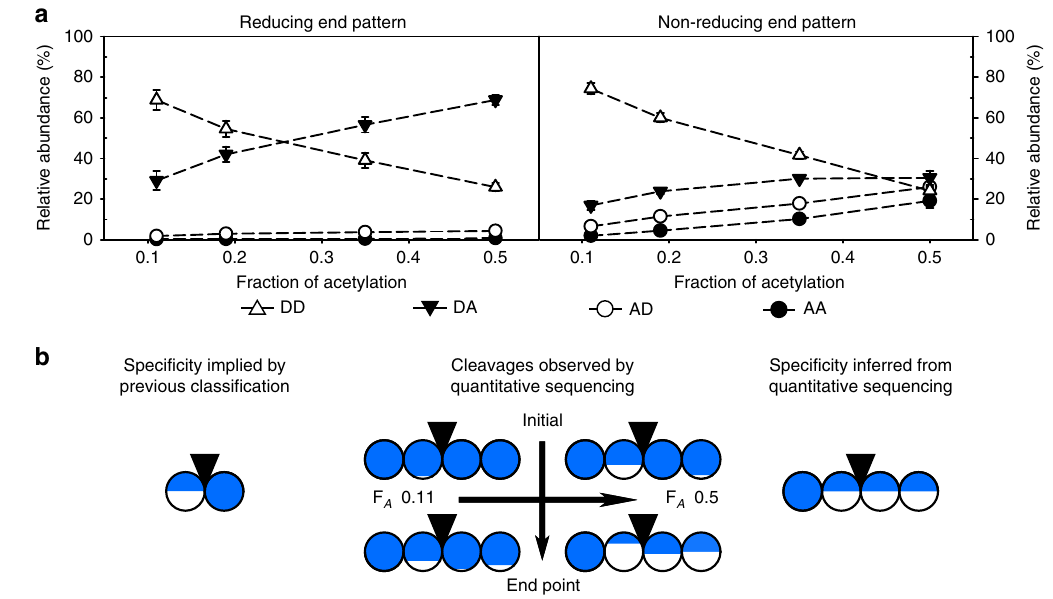
Fig. 2 Speci fi city of the representative class I chitosanase CSN-174 inferred from its products. ( a ) The patterns of acetylation of the two terminal sugar units were analyzed for different F A of the substrates by quantitative sequencing of the products at the endpoint of enzymatic hydrolysis. The molar fractions of all possible diads (DD, DA, AD, and AA) are shown. ( b ) The speci fi city of class I chitosanases implicated by the established qualitative classi fi cation system compared to the speci fi city of CSN-174 (a model class I chitosanase) inferred from the cleavages observed by the quantitative sequencing of its products ’ sugar moieties. Diad frequencies at the early time points of enzymatic hydrolysis are taken from Supplementary Table 5. Detailed oligomer compositions are shown in Supplementary Table 1. The circles are divided according to the percentage of the relative abundances (molar fractions) of GlcN (blue) and GlcNAc (white) at the two corresponding subsites, left, ( − 2) and ( − 1), and right, (+1) and (+2), of the catalytic cleavage site (indicated by a black inverted triangle). The mean values with standard deviations of at least three independent measurements of three independent enzyme batches are shown (Supplementary Tables 1 and for GlcN over GlcNAc is observed at the (+1) and (+2) subsites of all enzymes.